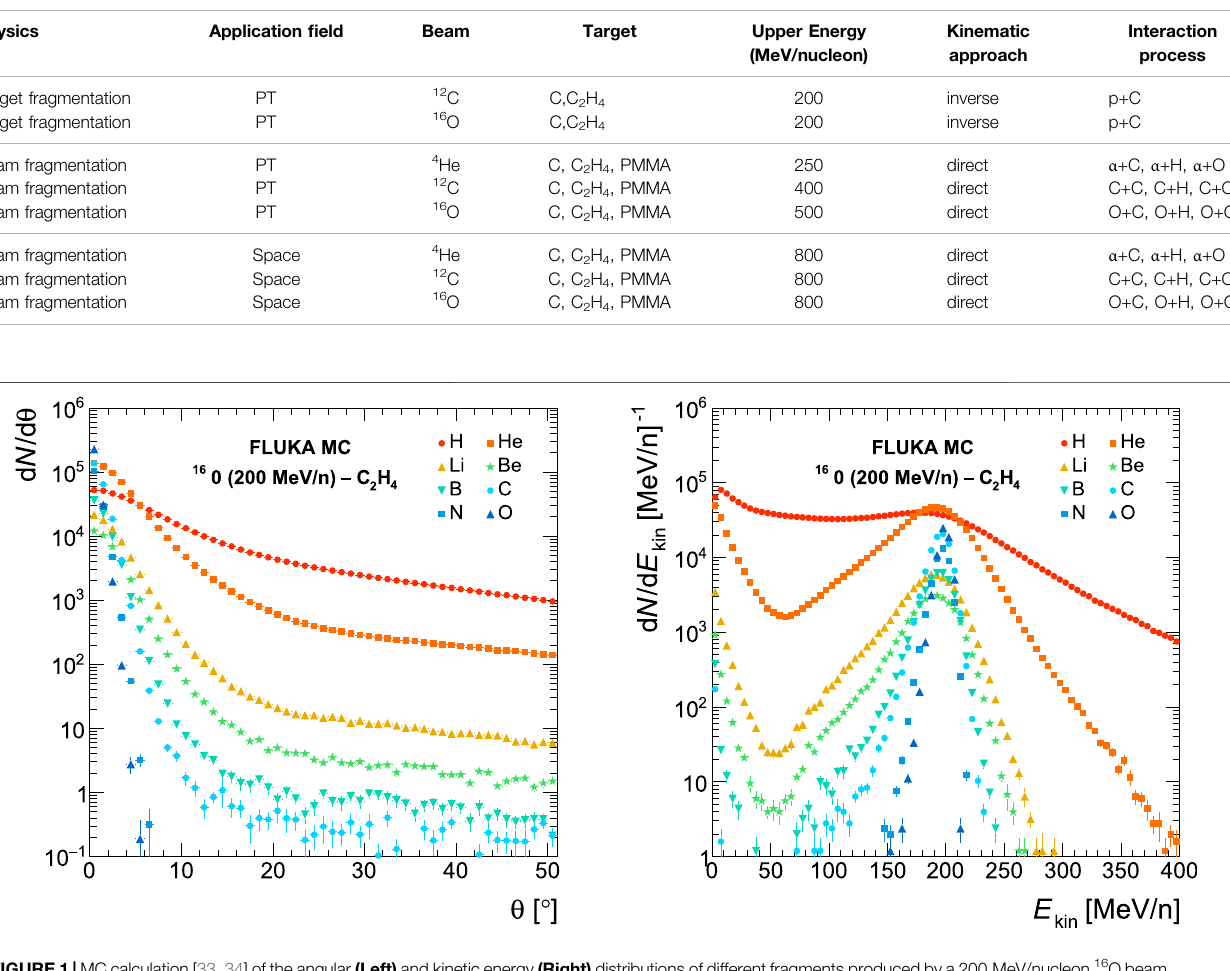
FIGURE 1| MC calculation [33, 34] of the angular (Left) and kinetic energy (Right) distributions of different fragments produced bya 200 MeV/nucleon 16 Obeam impinging on a C 2 H 4